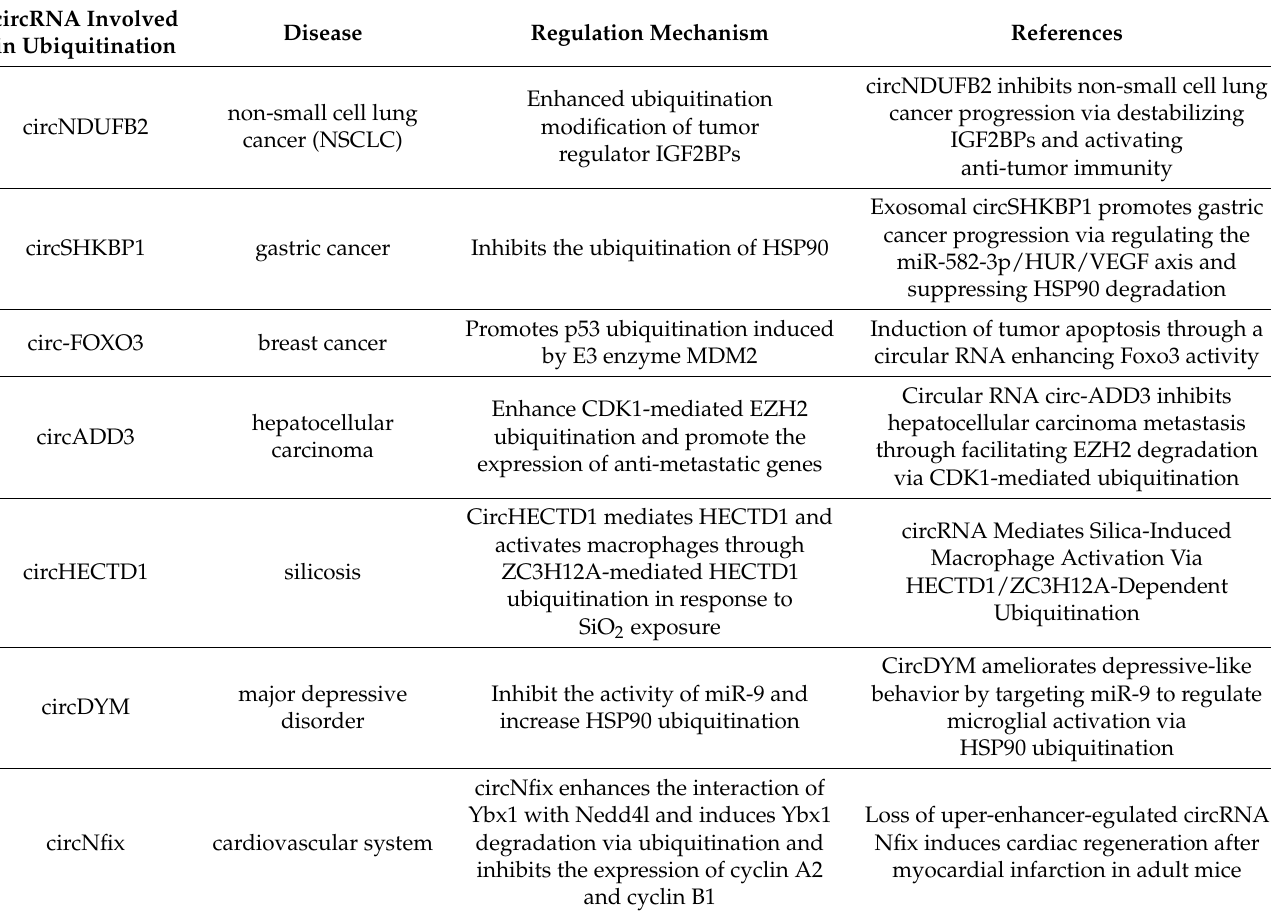
Table 1. SummaryoftheregulatorymechanismbasedoncircRNAinvolvedinubiquitinationmodification. circRNA